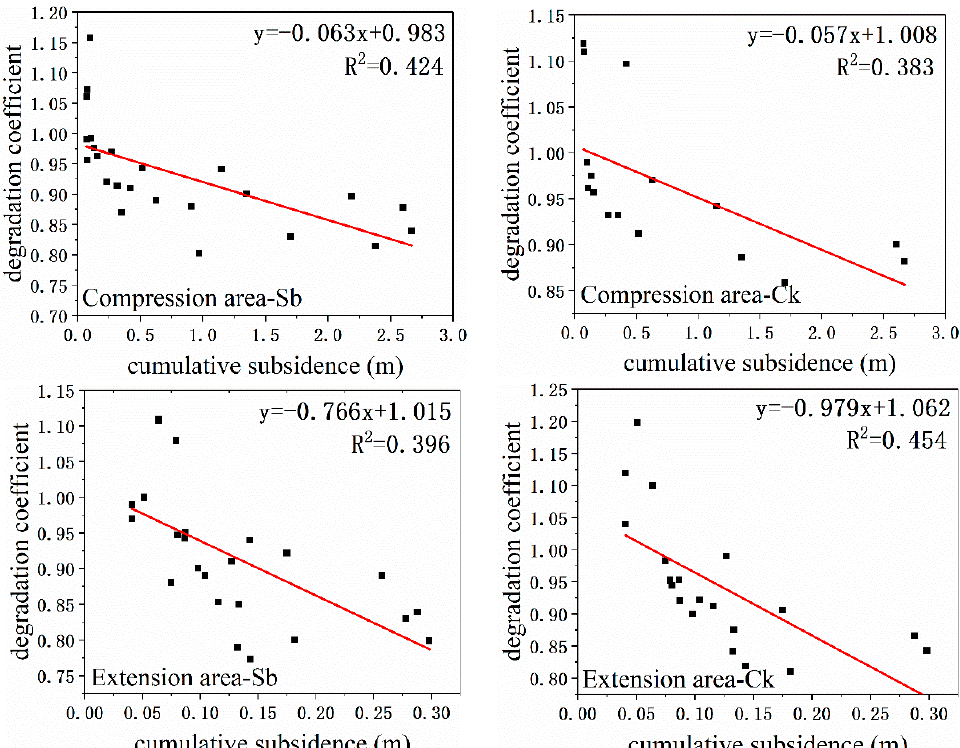
Figure 8. Relationship between degradation coefficient and ground subsidence at canopy scale.